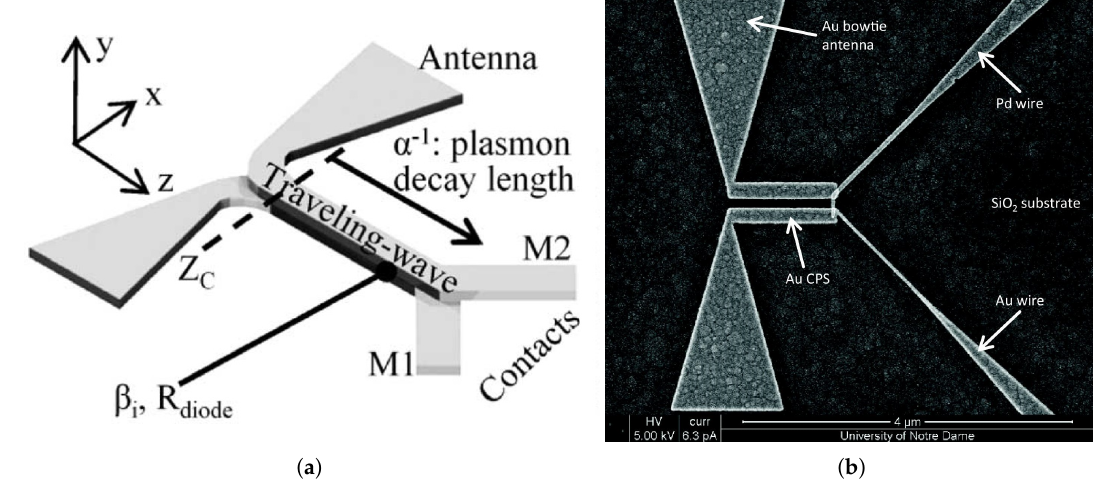
Figure 17. Impedance matching examples: ( a ) Traveling wave distributed MOM structure [33], ( b ) CPS to match antenna with thermocouple